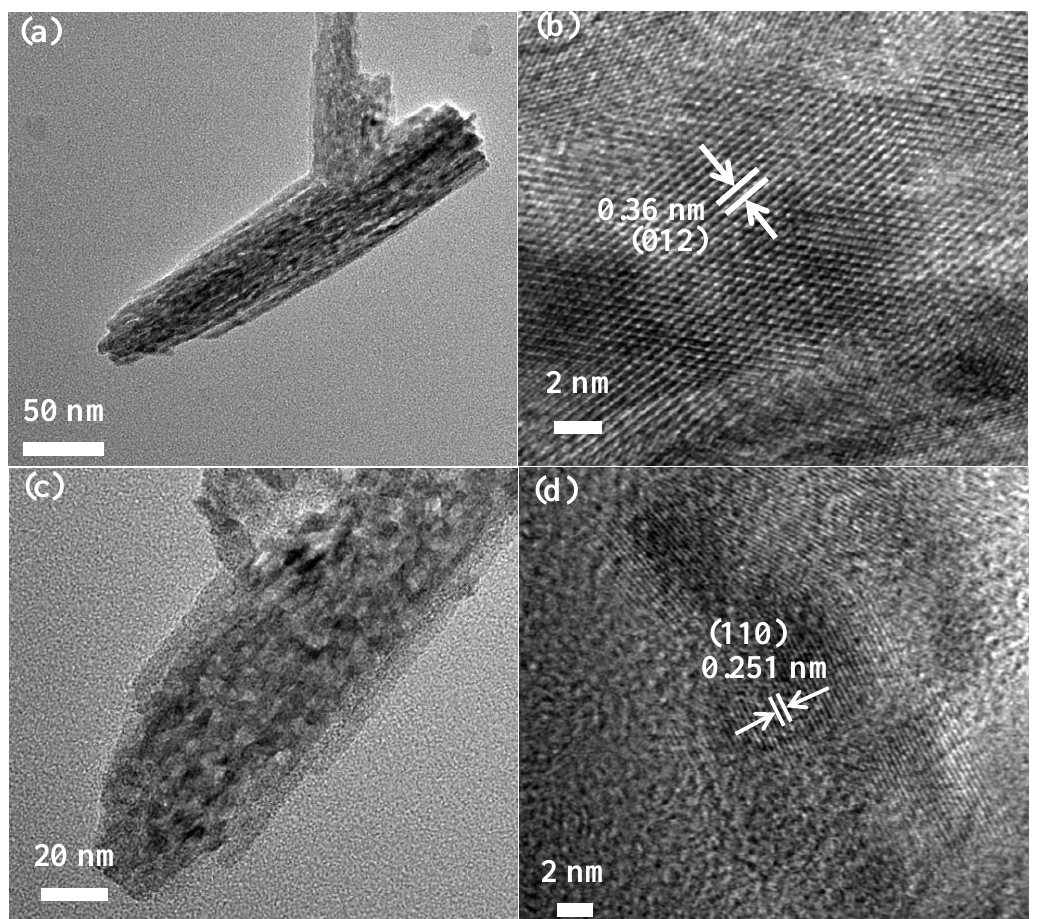
Figure 2. ( a ) TEM image of α-Fe 2 O 3 nanowire arrays ( b ) HRTEM image of α-Fe 2 O 3 nanowire arrays